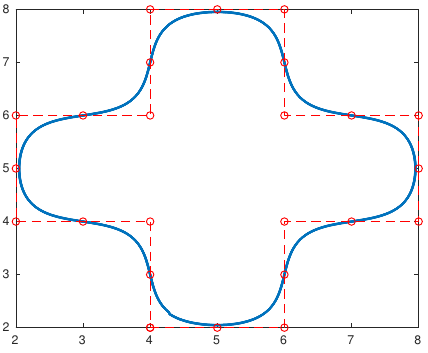
Figure 5. The limit function in 2d using five subdivision scales obtained by S 6 (19), where w = 1 In this figure, the original sampling is represented in ◦